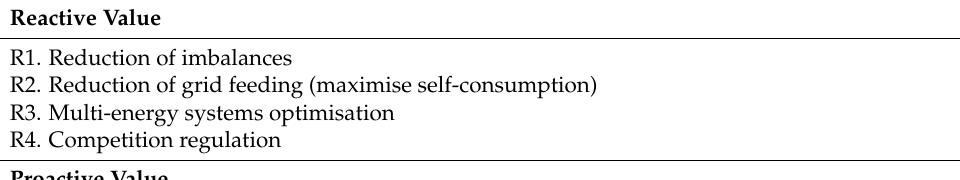
Table 1. Overview of the market values of enhanced solar power generation